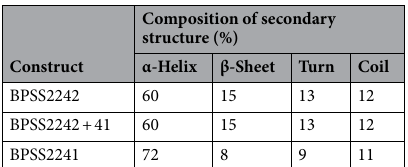
Table 1. Secondary structure contents of BpSDRs.